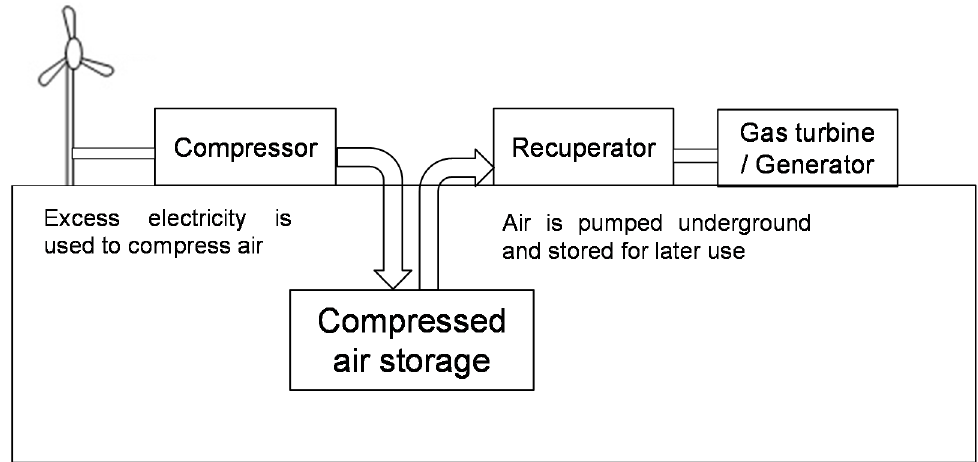
Figure 1. Main components of a compressed air energy storage system. The surrounding geomaterials mostly experience numerous cycles induced by mechanical processes when shallow storage is constructed to improve the distance between a wind farm and storage.